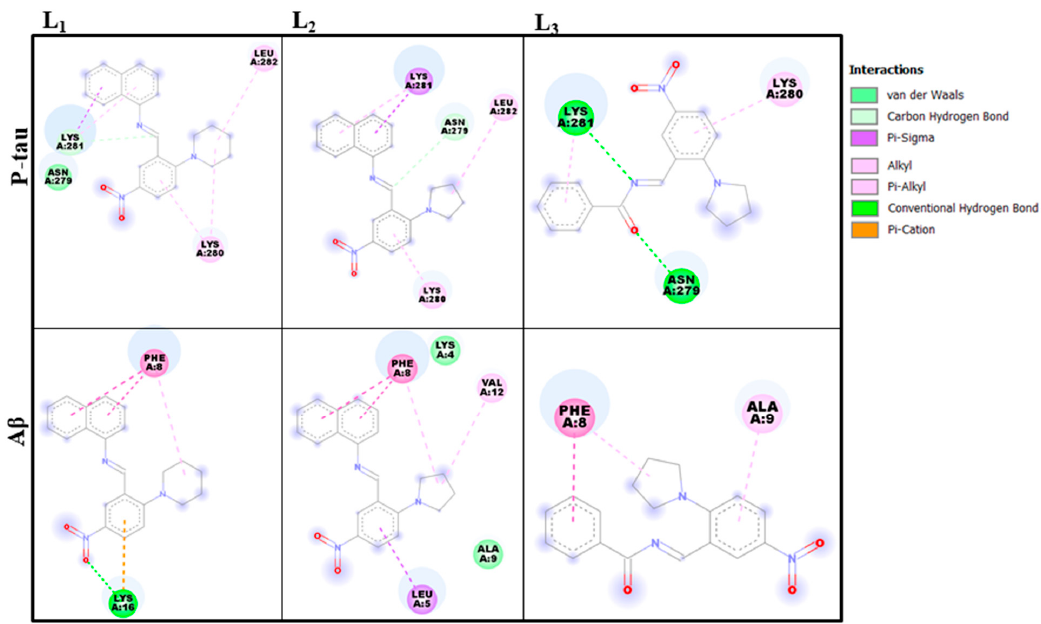
Figure 4. Two-dimensional representation of interactions between L 1–3 and proteins.